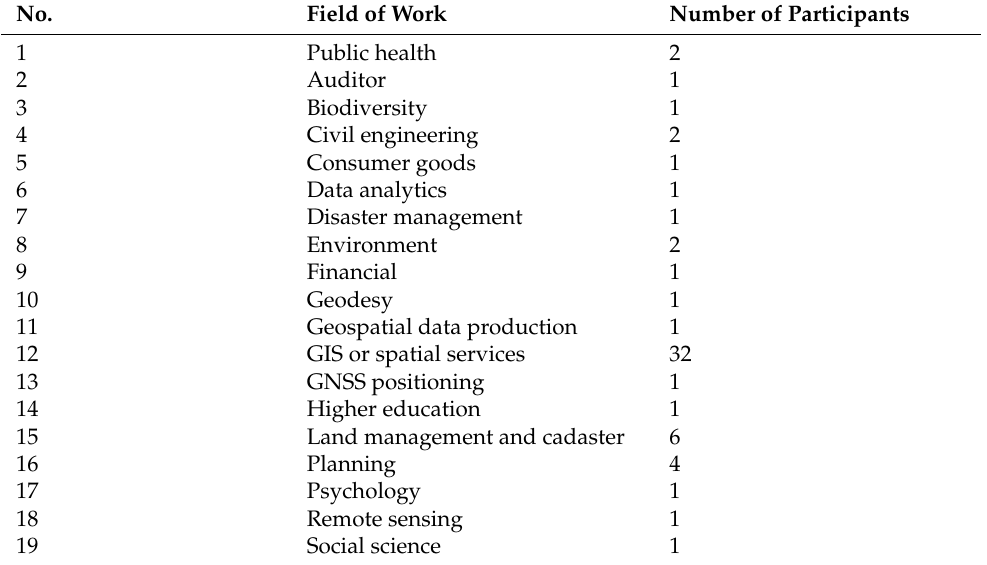
Table 2. Participants’ fields of